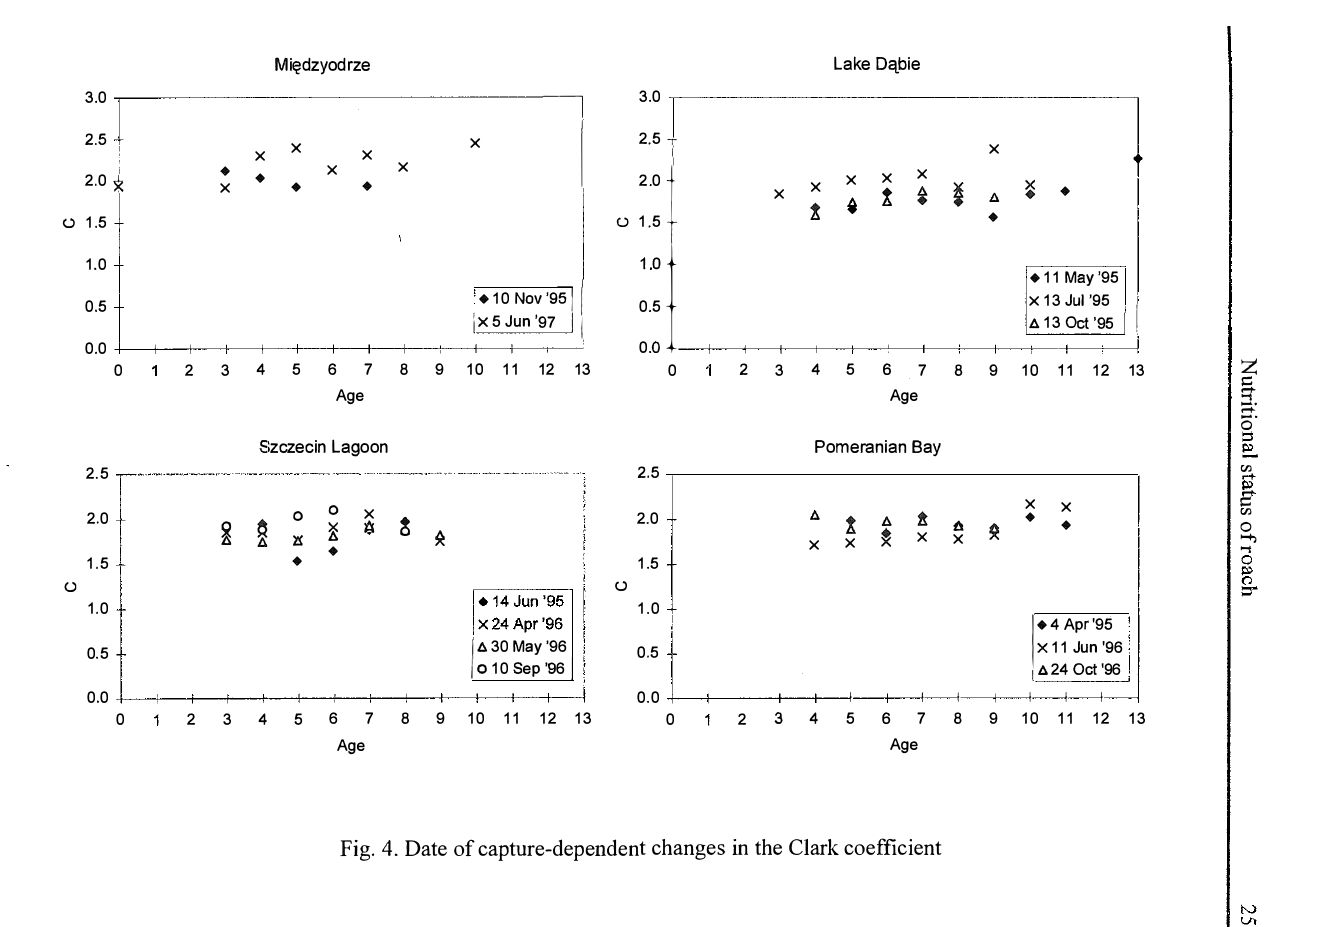
Fig. 4. Date of capture-dependent changes in the Clark